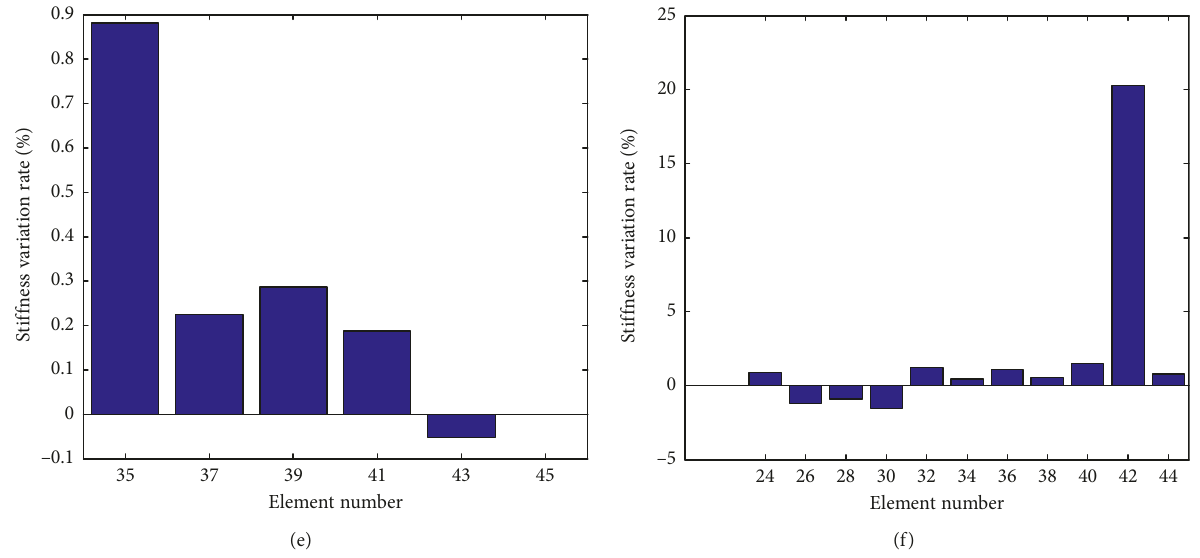
Figure 11: Damage detection using the expanded data contaminated by 1% noise: (a) displacement variations; (b) stiffness variation rate at lower chords; (c) stiffness variation rate at upper chords; (d) stiffness variation rate at diagonal elements; (e) stiffness variation rate at diagonal elements; (f) stiffness variation rate at vertical elements. In (a), the solid line indicates the horizontal displacement and the dashed line indicates the vertical displacement.